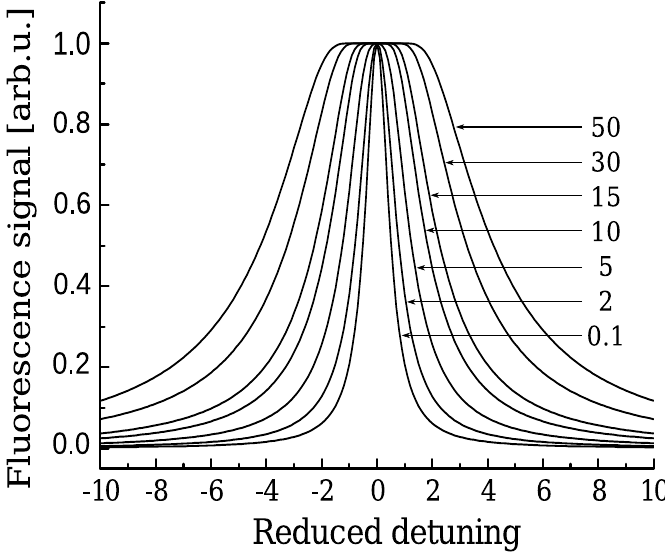
Figure 2. Dependence of the absorption signal J Equation (5) on the reduced detuning δ / Γ e for different values of the pumping parameter P pum Equation (6) (shown as labels of the curves). All curves are unity-normalized at the line center δ =